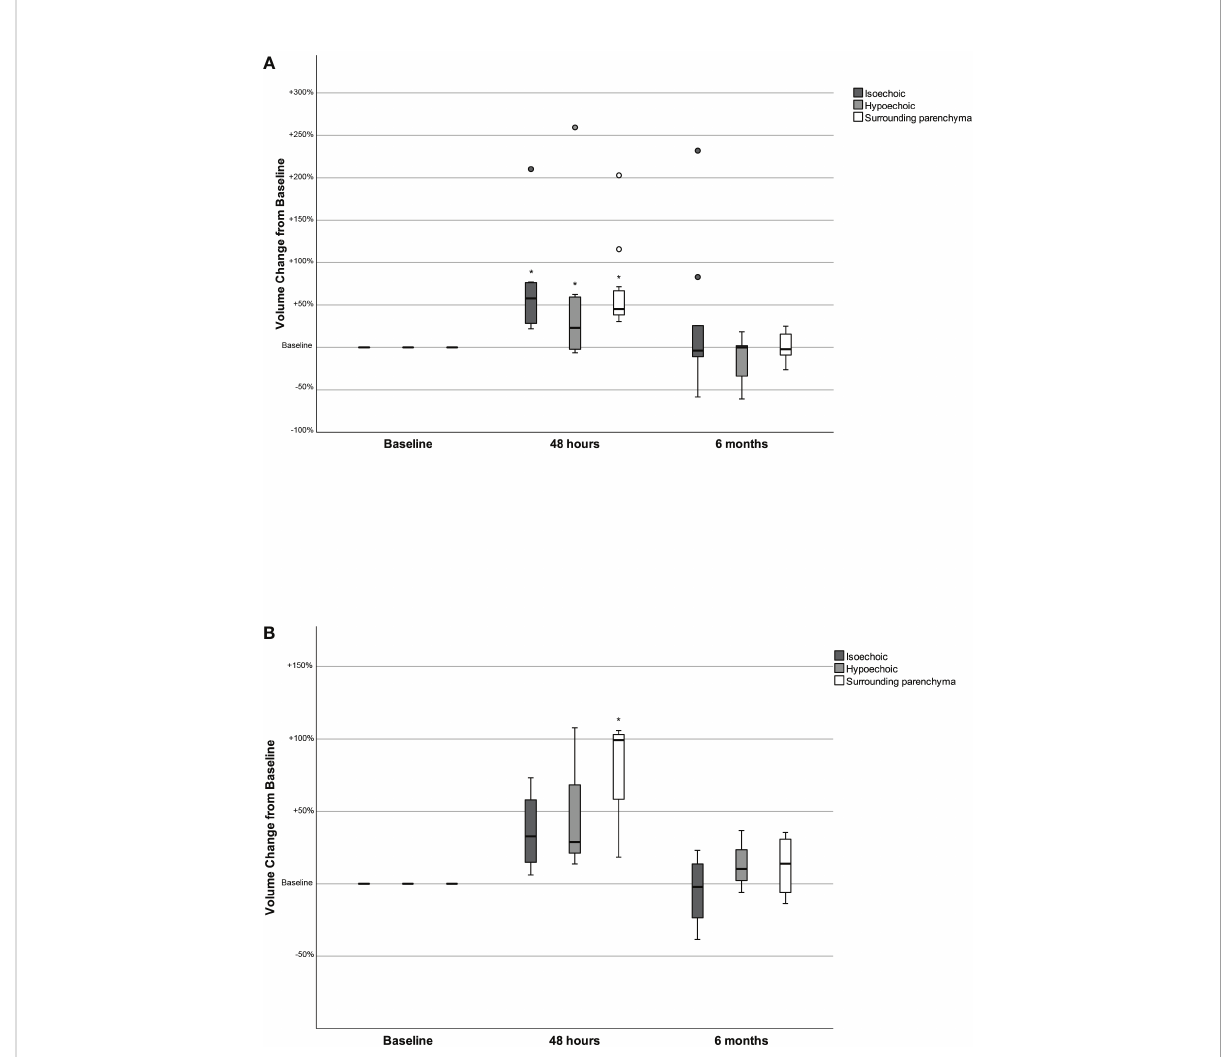
FIGURE 2 Changes in the volume of isoechoic and hypoechoic nodules and in the surrounding parenchyma volume 48 hours and 6 months after the administration of human recombinant TSH, presented as % change from baseline, in women (2A) and men (2B) . *p<0.05 Volume at 48 hours versus baseline (Wilcoxon signed-rank test)